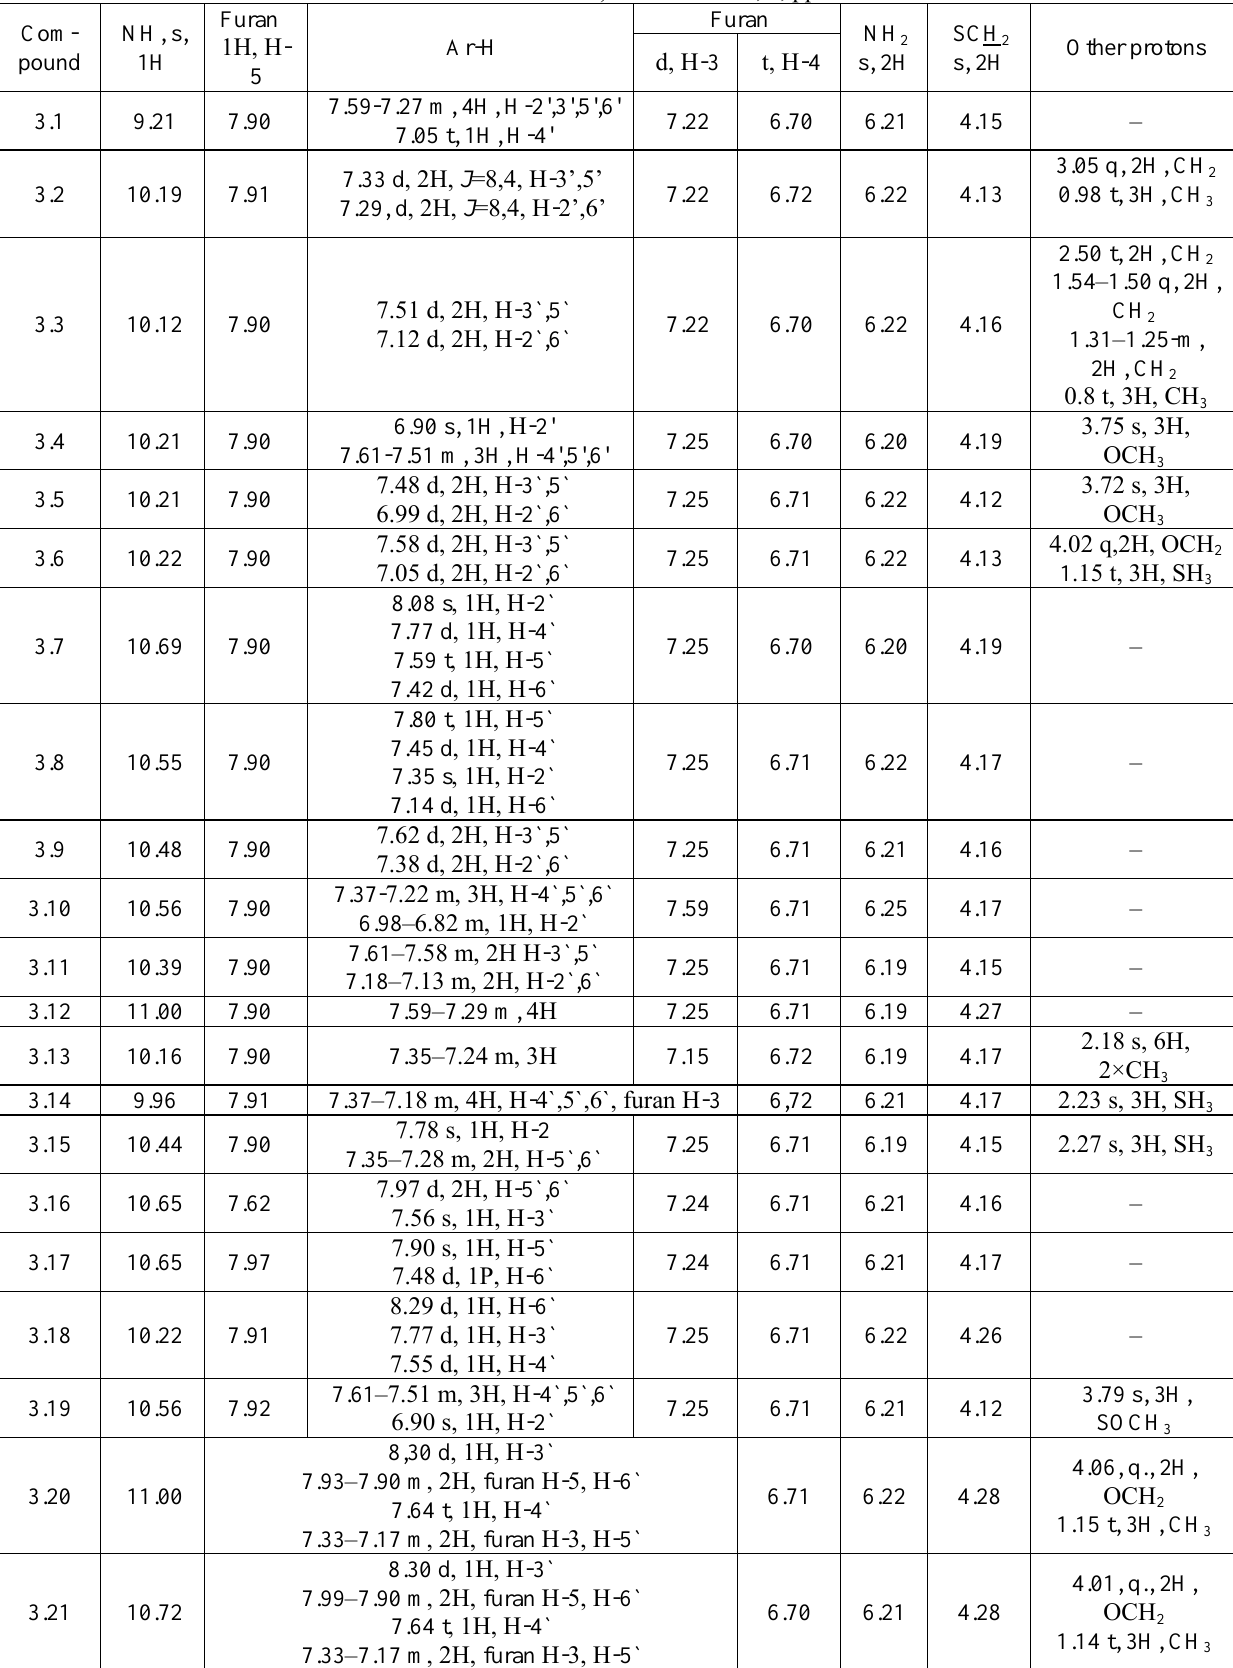
Data of 1 H NMR spectra of synthesized 2-((4-amino-5-(furan-2-yl)-1,2,4-triazol (4H)-3-yl)-sulfanyl)-N- acetamides ( 3.1-3.21 ) chemical shift, δ,